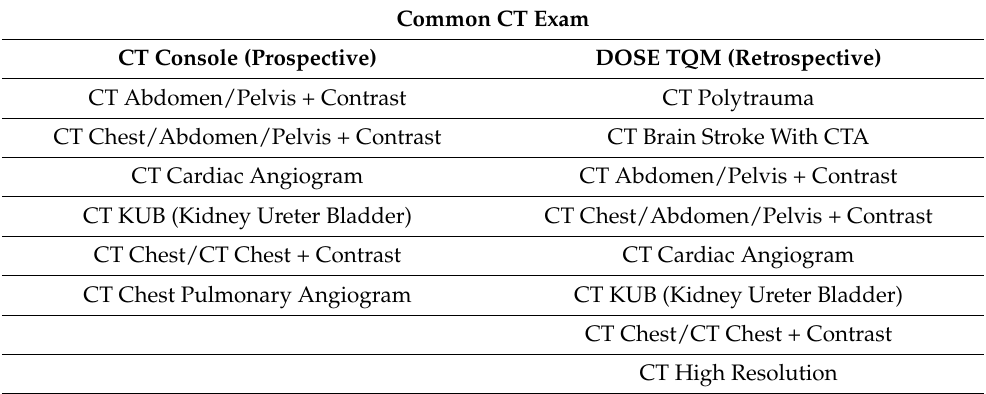
Table 2. Common CT studies exceeding NVs using both the CT system console (prospective) and DOSE TQM (retrospective) dose monitoring tools.